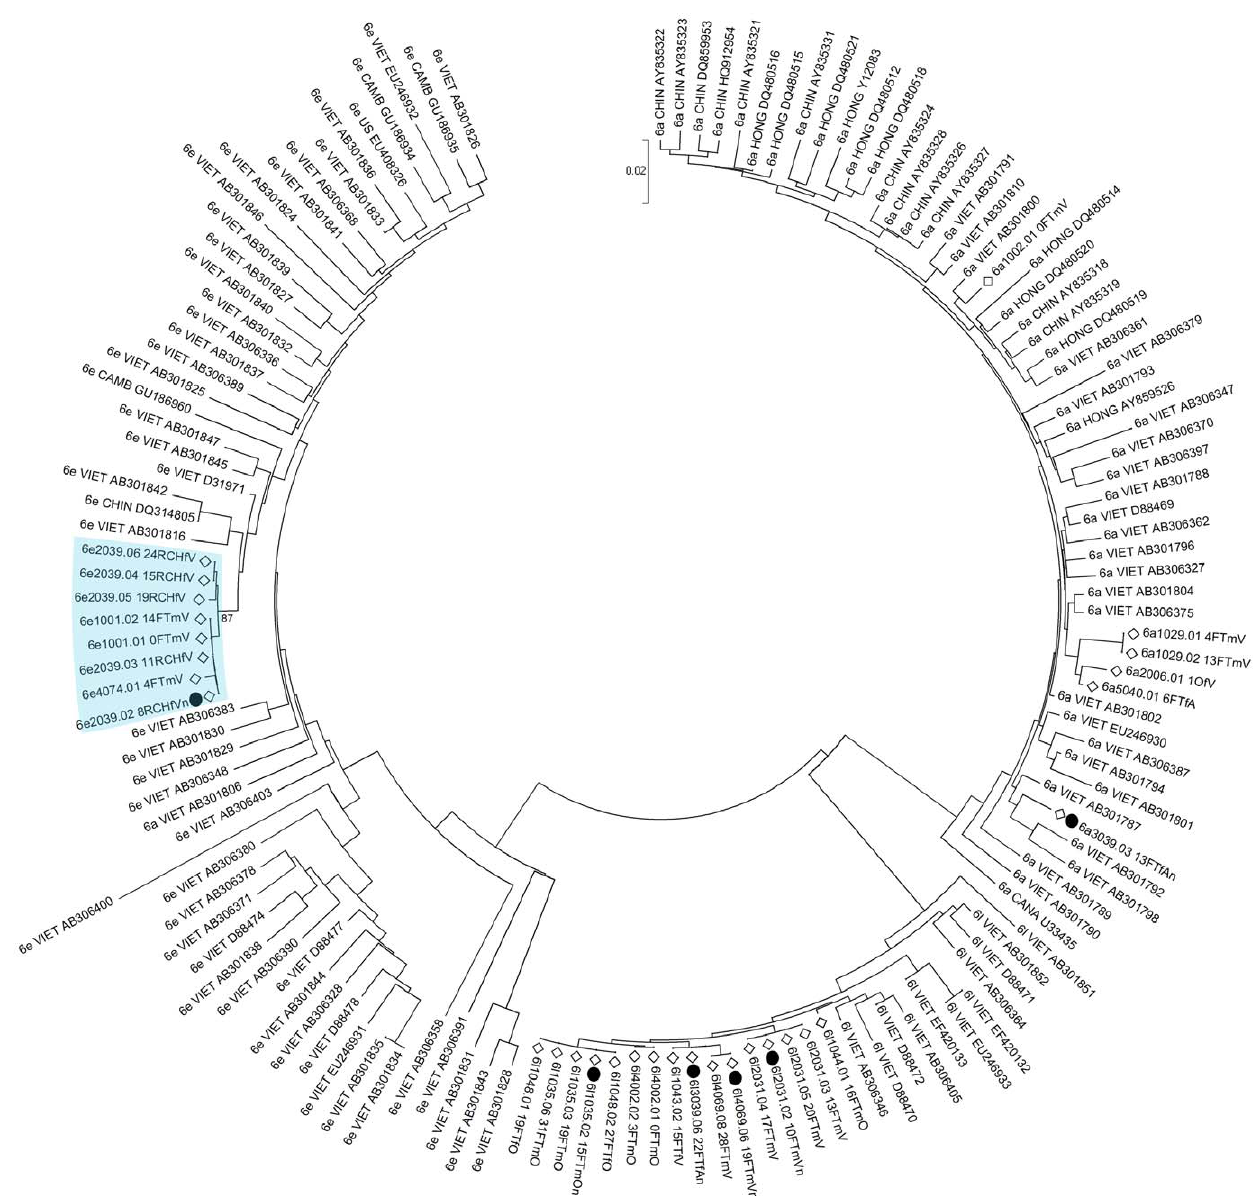
Figure 6. Neighbor-joining analysis of HCV genotype 6a , 6e , and 6l core sequences. Comparison sequences were randomly selected genotype 6a , 6e , and 6l sequences from the LANL HCV database. Study participants are denoted by diamonds. The first four letters of the name of the country of origin of LANL sequences is included in the ID. Phylogenetic clusters defined by bootstrap analysis (cut-off 70%) with infections from multiple individuals in the study are highlighted in blue and bootstrap values for these clusters are indicated. Newly acquired infections and changes in viral sequence are denoted using black-filled circles.